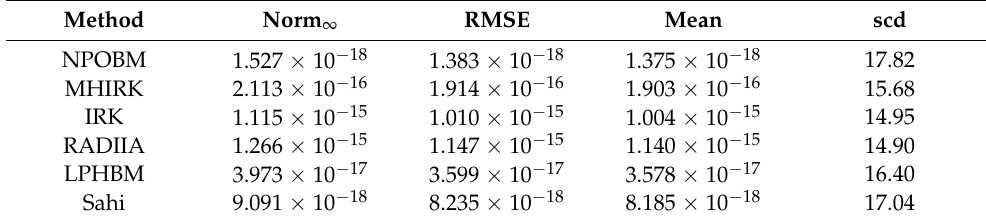
Table 6. Numerical results for Problem 2 with NS = 2 7 where x ∈ [ 0,5 ] .